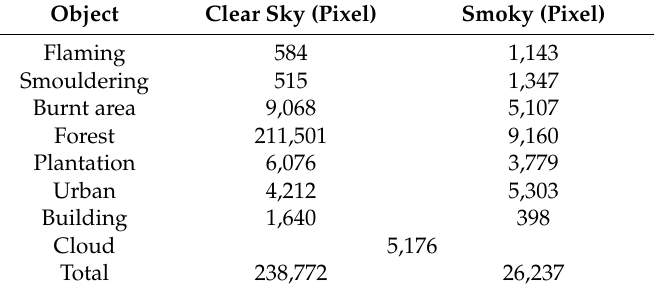
Table 2. Sample areas (in pixel) for peatland combustion algorithm development. Object Clear Sky (Pixel) Smoky (Pixel) Flaming